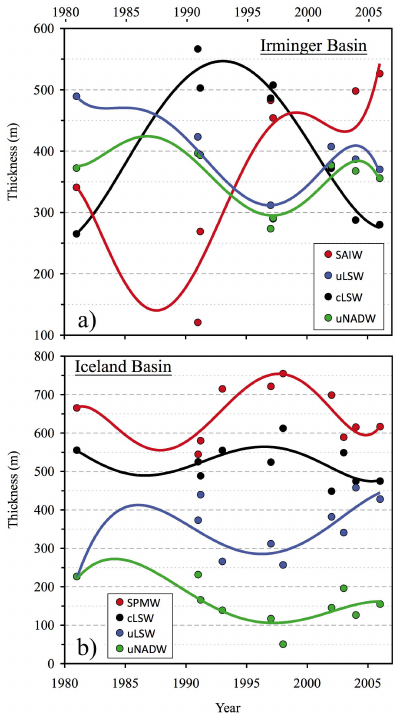
Fig. 5. Scatter plots with overlaid polynomial fits of different orders showing the temporal evolution of layer thicknesses in the Irminger (5a) and Iceland (5b) basins. The thicknesses were calculated ap- plying Eq. (A4) given in Appendix A1. The Iceland basin shows a thicker, more developed c LSW layer than in the Irminger basin given the deeper bathymetry of the former and also because c LSW forms mainly in the Irminger, but develops further towards the Ice- land basin. The propagation of Irminger formed waters into the Ice- land basin is also the reason for the slight temporal delay observed for the c LSW peak in the Iceland basin (towards 1997) with respect to the Irminger basin (where it occurs around